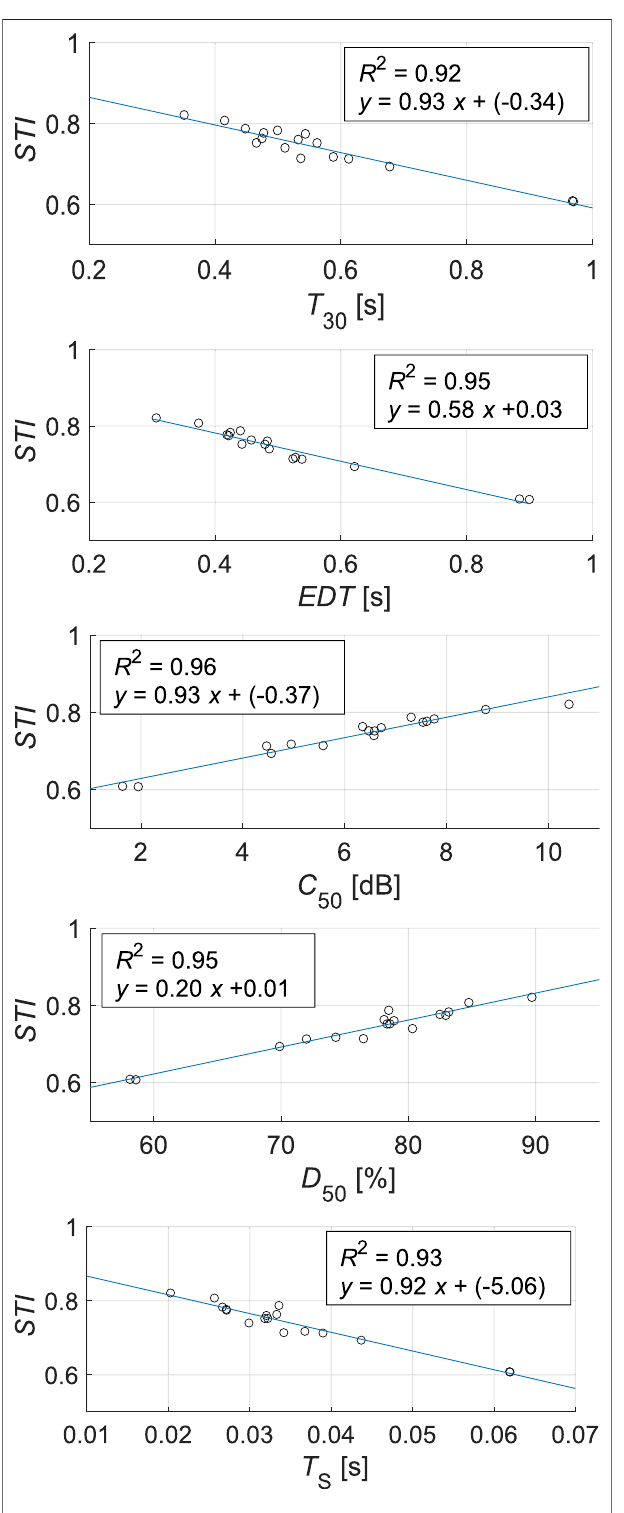
FIGURE 2 | Linear regression models between speech transmission index and other room acoustics parameters.